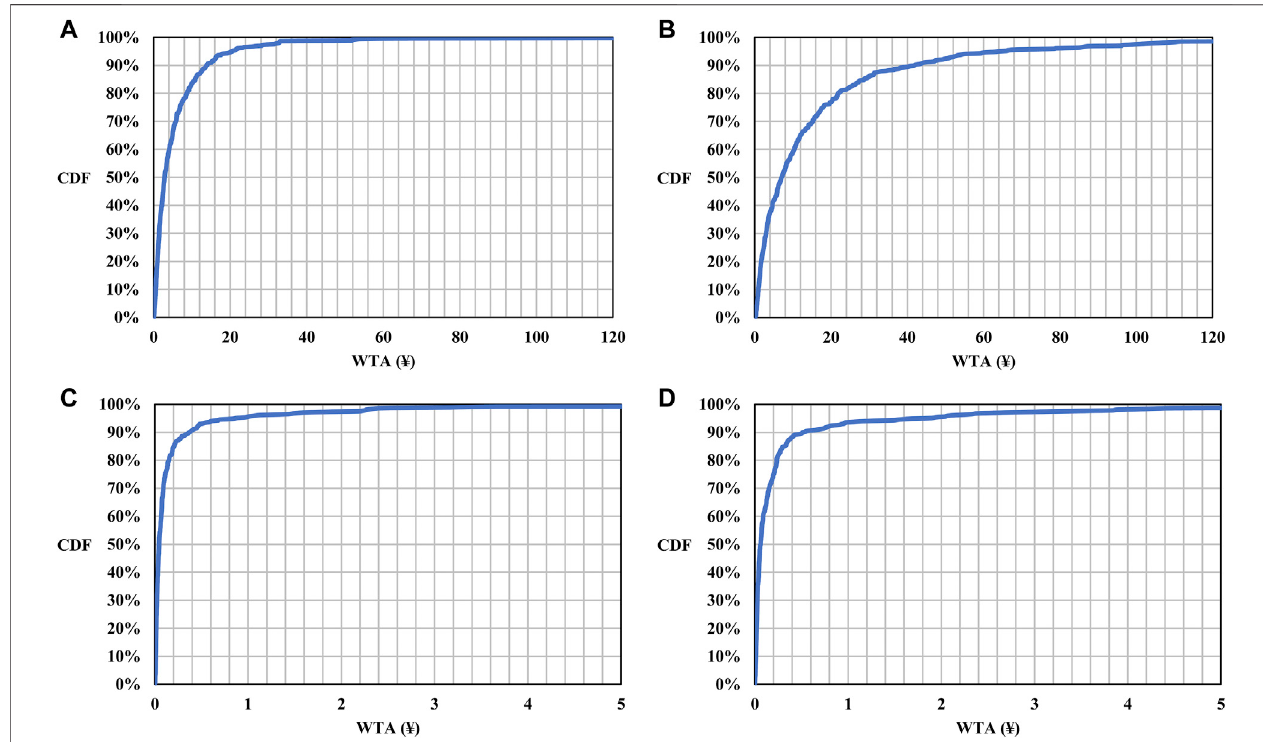
FIGURE1| CumulativedistributionofWTAforinterruptions. (A) AC_D30. (B) AC_D60. (C) EK_D30. (D) EK_D60.Notes:(i)thehorizontalaxisistheWTAvaluesandthe vertical axis is the cumulative probabilities. (ii) For AC interruptions, extreme WTA values that are larger than ¥100 have been deleted from the fi gures, composed of two observationsforD30and14observationsforD60.(iii)ForEKinterruptions,extremeWTAvaluesthatarelargerthan¥5havebeendeletedfromthe fi gures,composedoftwo observations for D30 and observations for D60.